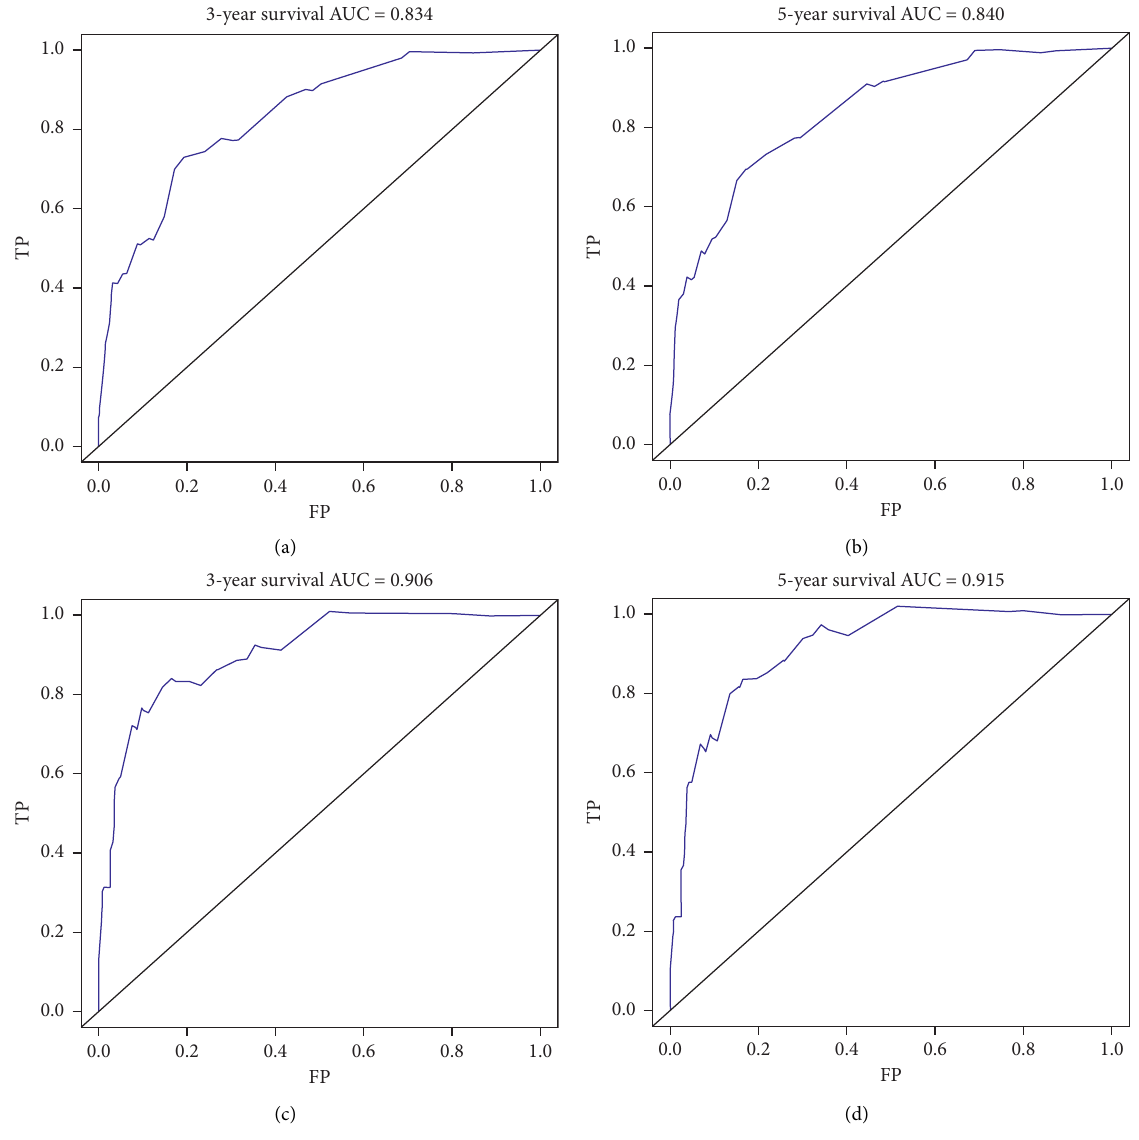
Figure 3: Receiver operating characteristic curves (ROC) for assessing the performance of predicting 3-year (a) and 5-year (b) overall survival and 3-year (c) and 5-year (d) cancer-specific survival in the training